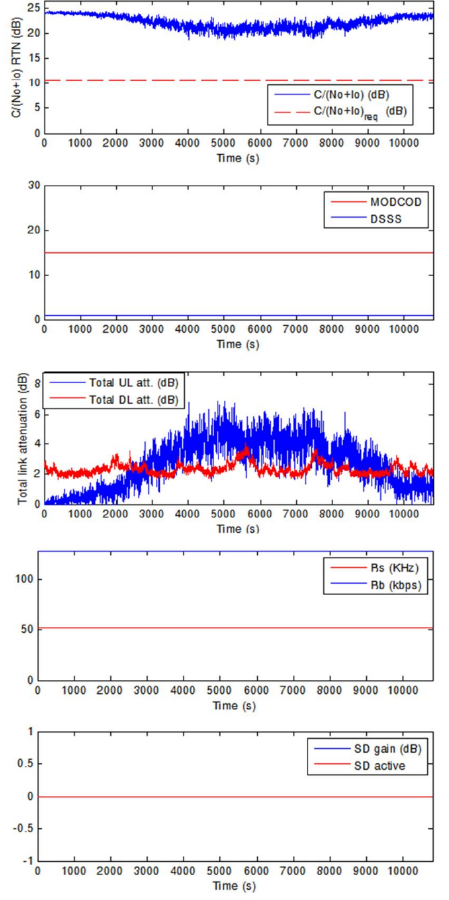
Figure 7. Adaptive strategy operation for UTA terminals in Ku band